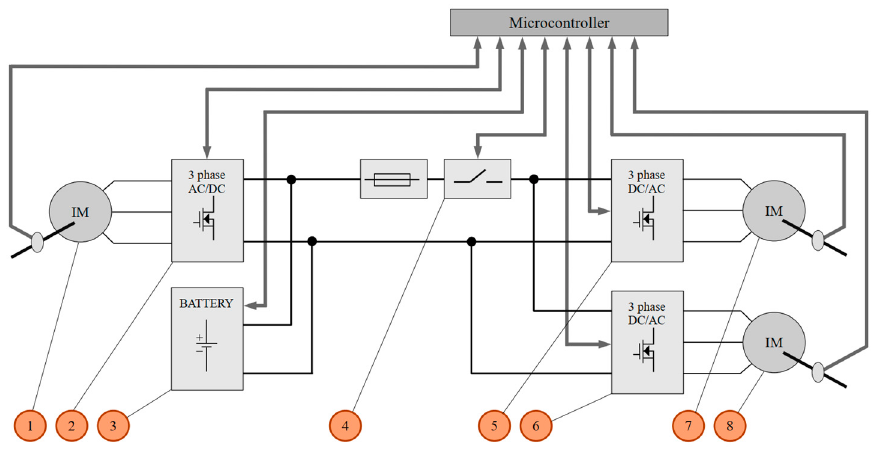
Figure 2. Block diagram of the hybrid trailer drive. 1, 7, 8—induction machine; 2, 5, 6—three phase DC/AC inverters; 3—battery; 4—circuit breaker (author: Petr